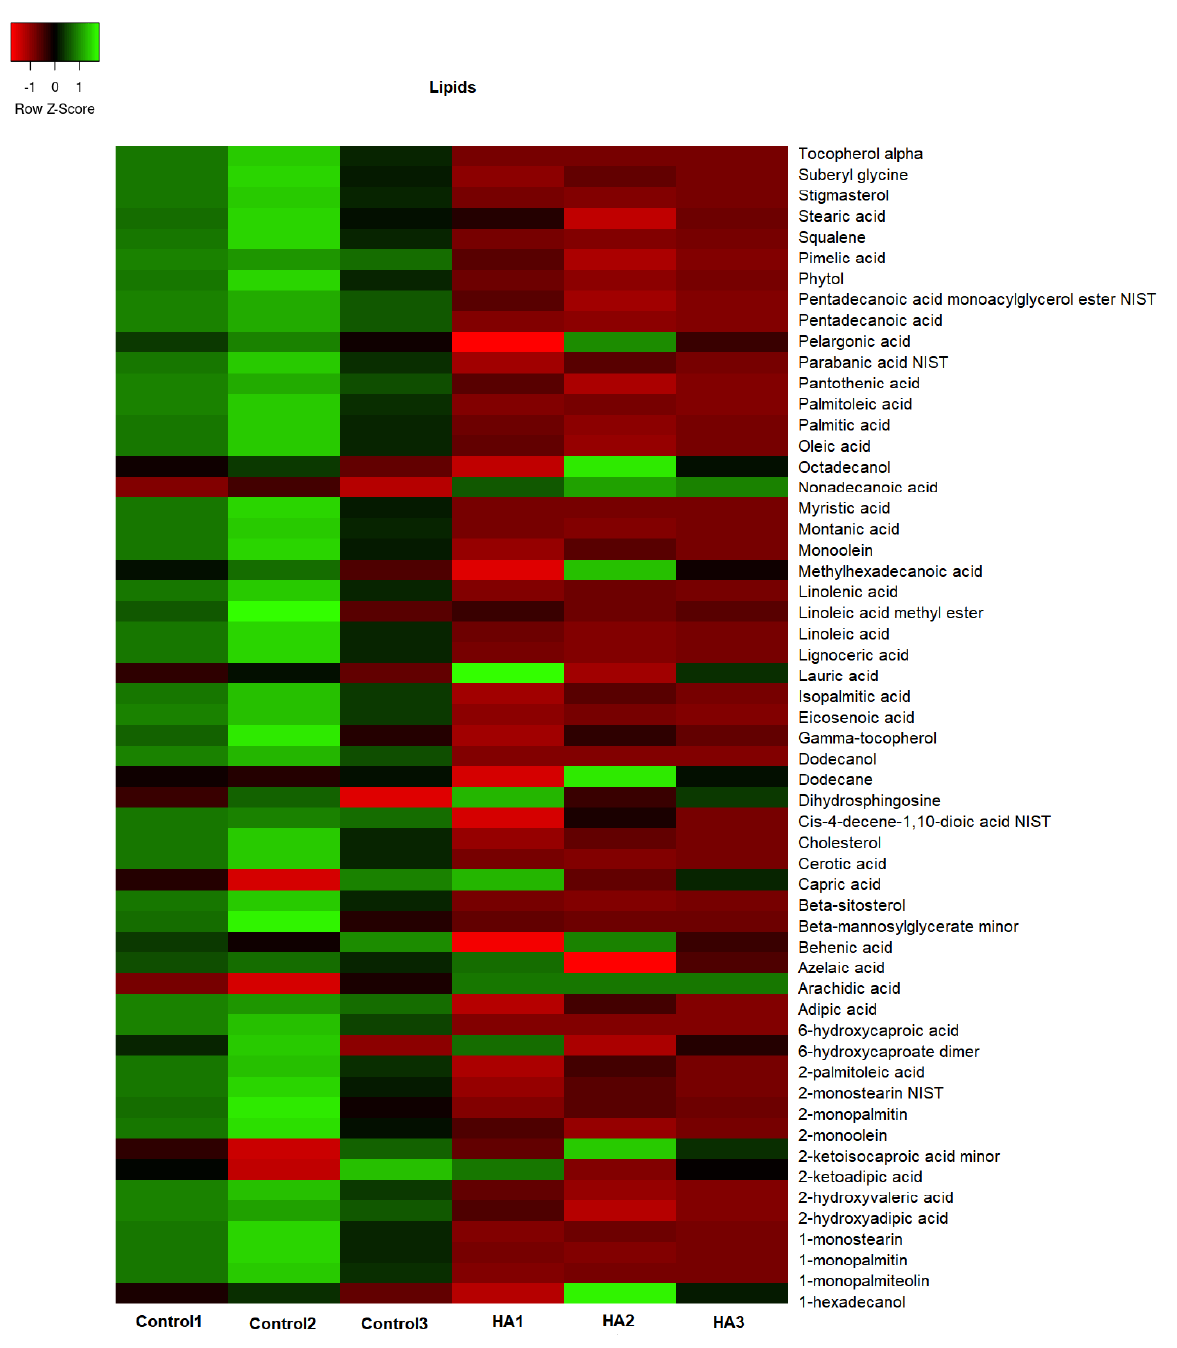
Figure 8. The concentration map of lipids (heat map of scaled concentrations) by plants treated with humic acids (HA) or not (Control).